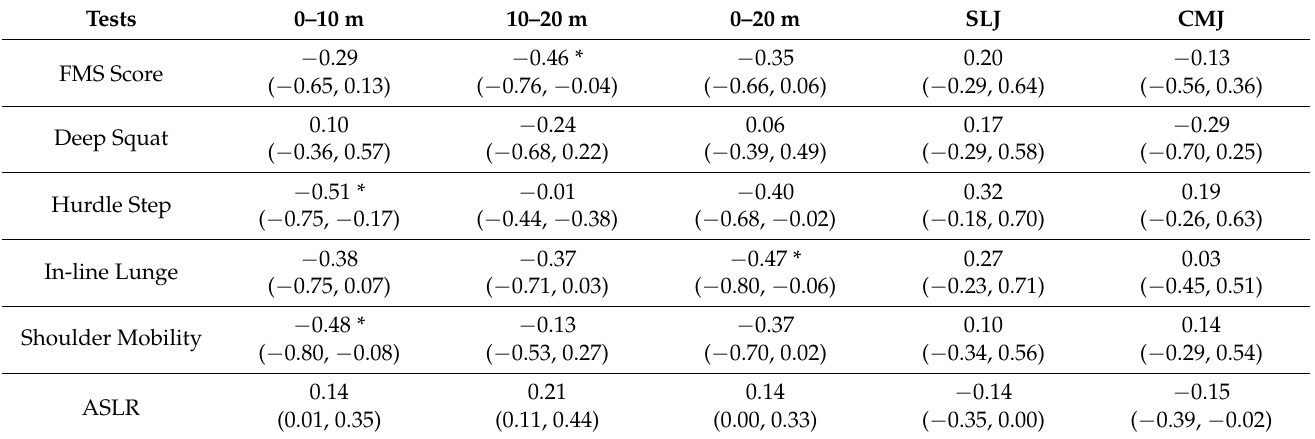
Table 2. Associations between FMS and athletic performance (r, 95%